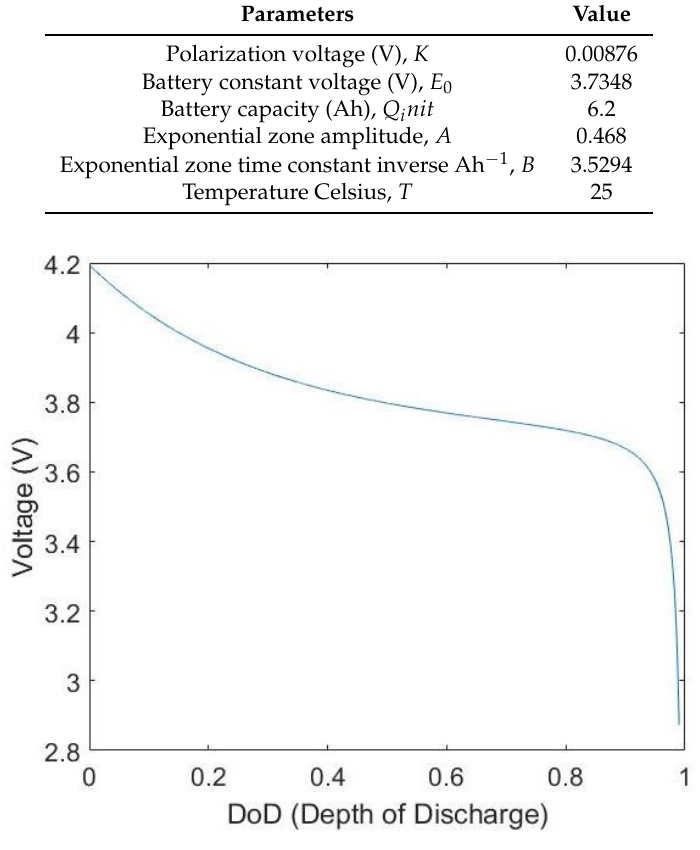
Figure 6. Battery-voltage variance based on depth of discharge